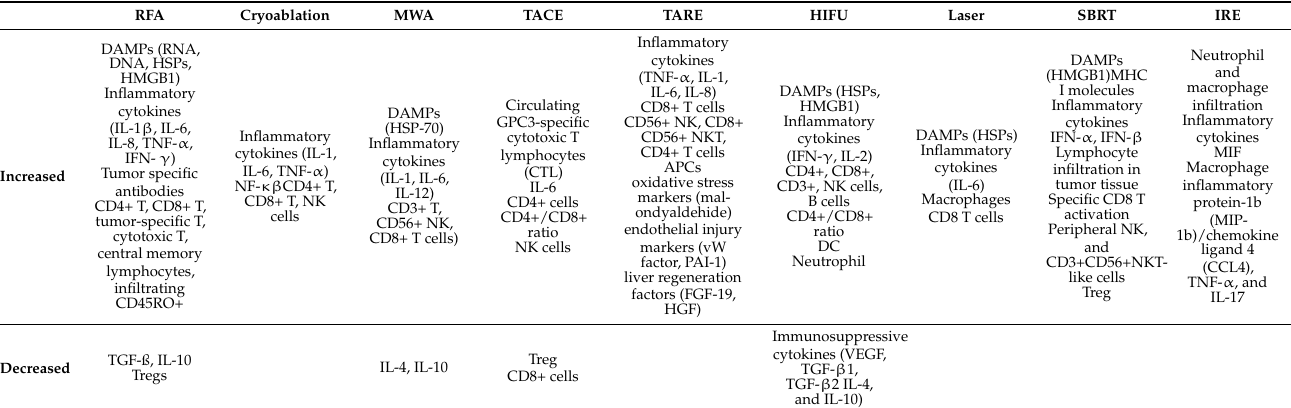
Figure 1. Locoregional therapies. TACE: trans-arterial chemoembolization; TARE: trans-arterial radioembolization; RFA: radiofrequency ablation; MWA: microwave ablation; IRE: irreversible electroporation; HIFU: high-intensity focal ultrasound; SBRT: stereotactic body radiation therapy. Table 1. Summarized immunological effect of